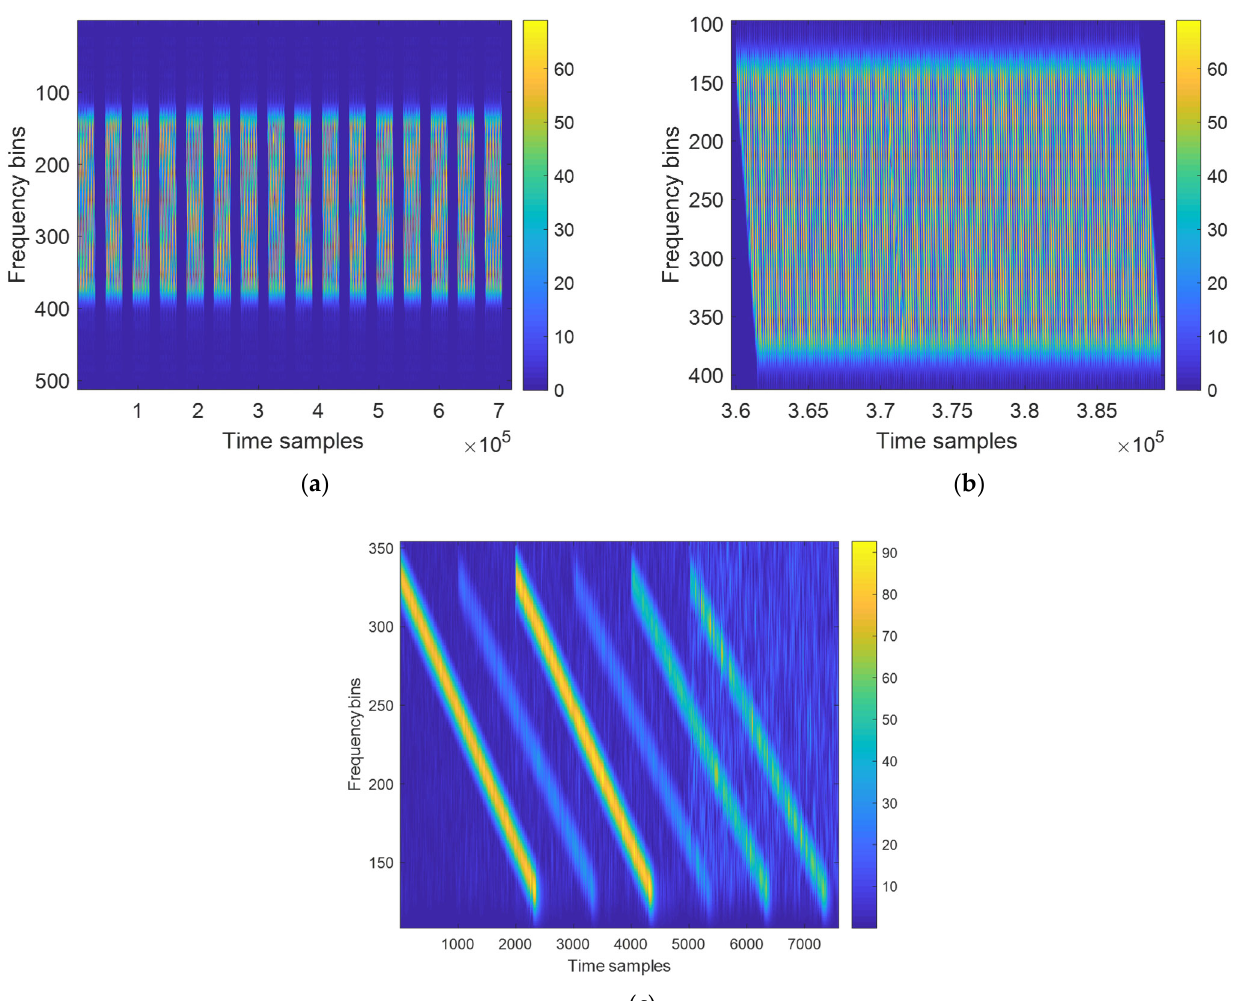
Figure 13. ( a ) Time–frequency analysis result of the FBMC chirp-based jamming signal; ( b ) the result with dense false target spacing; ( c ) the result with sparse false target spacing.